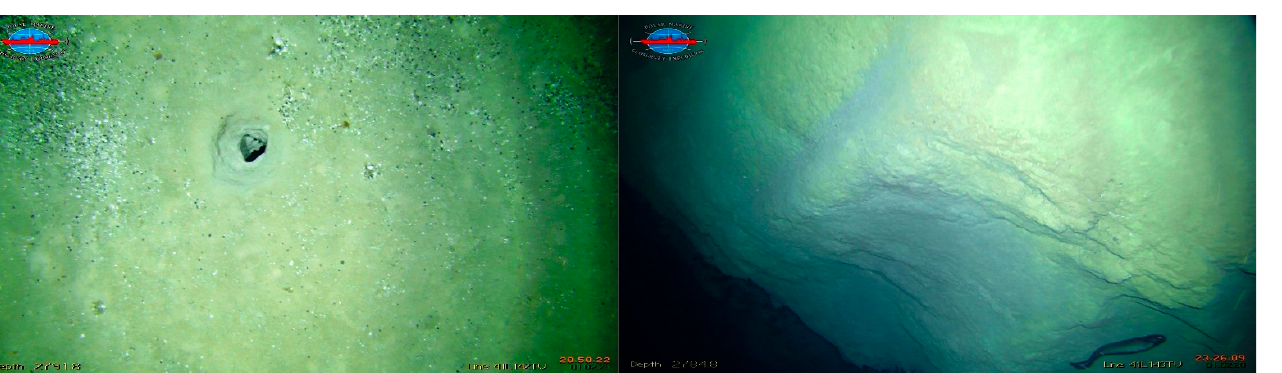
Figure 9. On the ( left ) the “hole” in the sediments; on the ( right ) lithified sediments in the upper part of the flank of the fault.